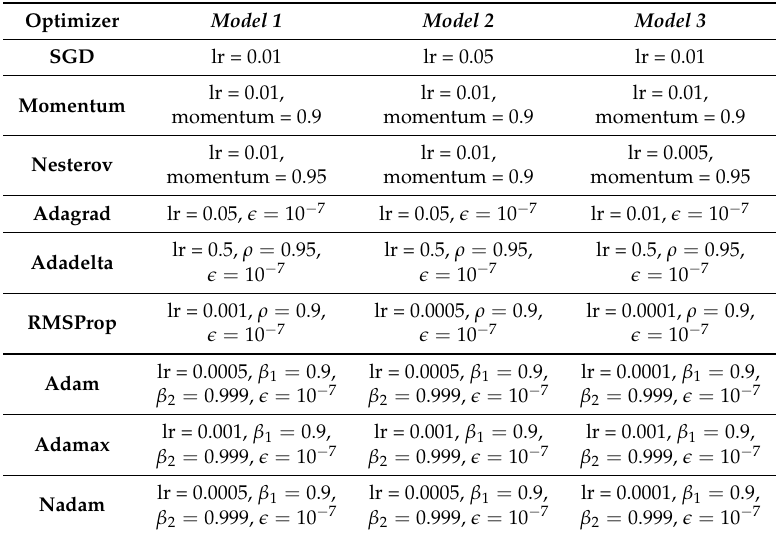
Table A2. Hyperparameters used on CIFAR-10